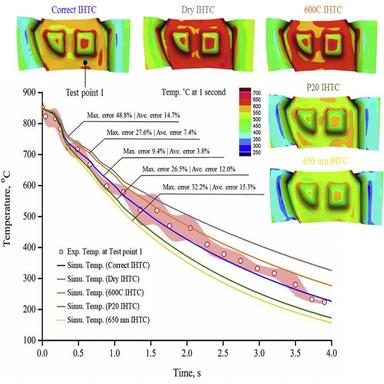
The simulated temperature evolutions using different IHTC evolutions.